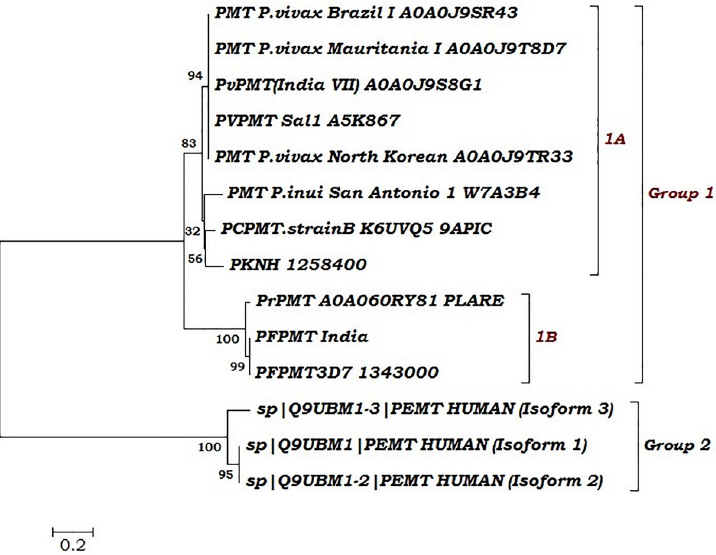
Fig 2. Phylogenetic analysis of Ind_ Pf PMT is shown with other pmt orthologues in Plasmodium species using neighbor joining method.